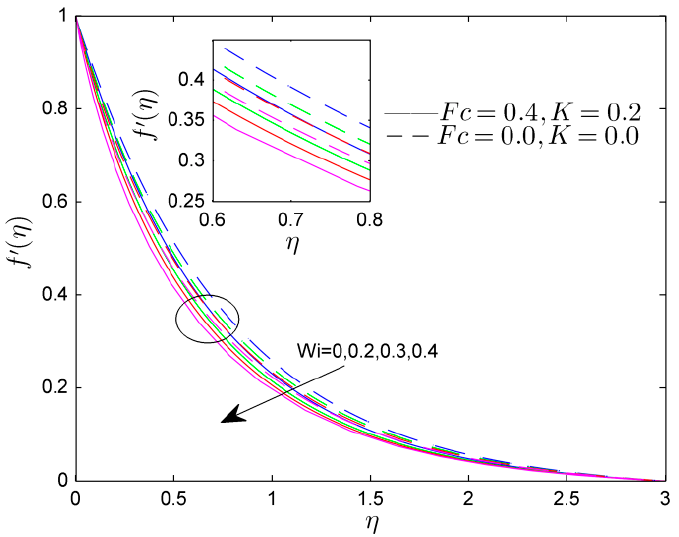
Figure 6. Effect of Weissenberg number (𝑊𝑖) on 𝑓 (cid:4593) (𝜂) when 𝑀 = 0, 0.5 .